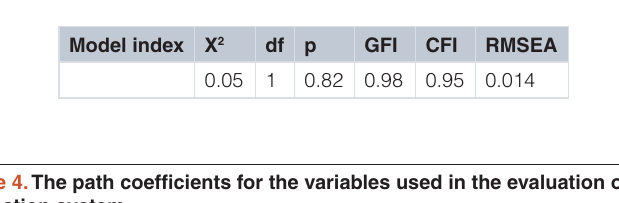
Table 3. Goodness of fit indices for the model (N=127).